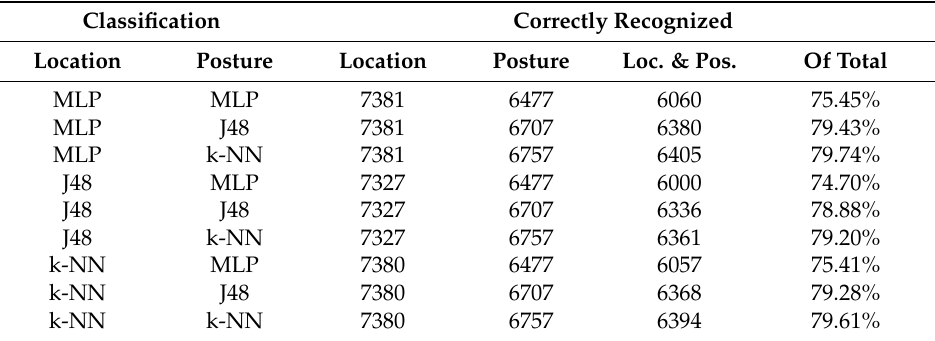
Table 9. Cross-validating AI